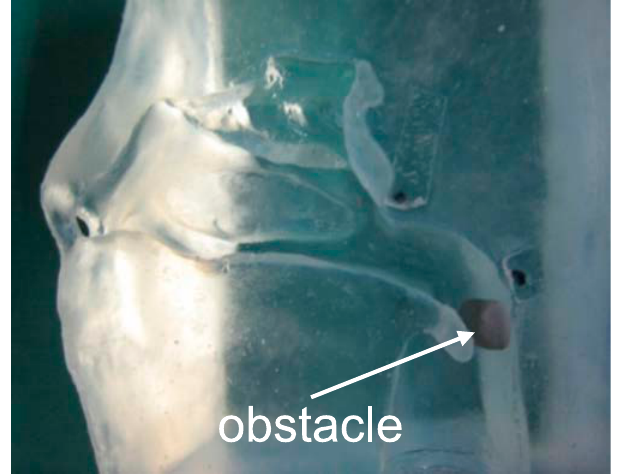
Figure 2 The artificial upper-airway model with an obstacle at the posterior end of the nasopharynx. The life-size, artificial, soft-silicon, upper-airway model of a healthy 5-year-old Japanese child (Koken Co., Ltd, Japan). The obstacle was placed at the posterior end of the nasopharynx in this model.